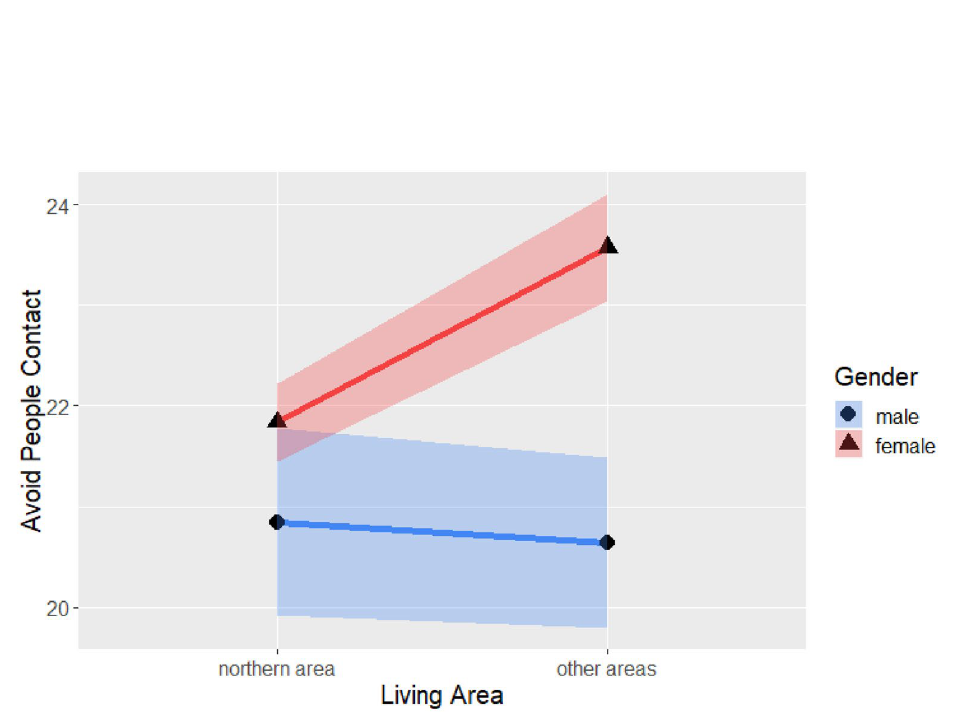
Figure 9. Avoiding human contact with gender and